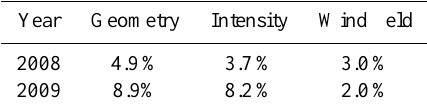
Table A1. R p values for the SEF region, reference years 2008 and 2009. Geometry: station network geometry; Intensity: a priori emis- sion field modulation; Wind field: meteorological data